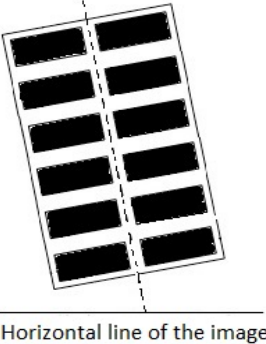
Figure 4. Adopted cells for panel’s orientation.